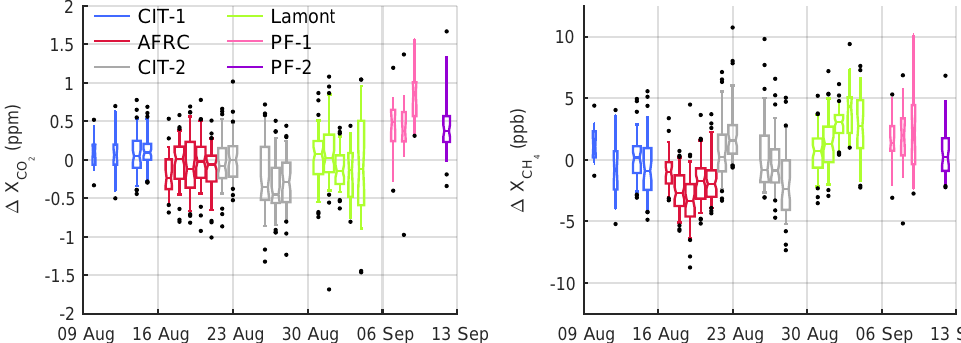
Figure 3. Differences between the TCCON and the mFTS products that are unadjusted except overall scale factors have been applied to the : 1.0073). Box plots width represents number of comparison points. They are drawn with the center line as : 0.9987; X CH mFTS data (X CO 4 2 median; the center box is the middle 50% range of data and the whiskers are the 90%